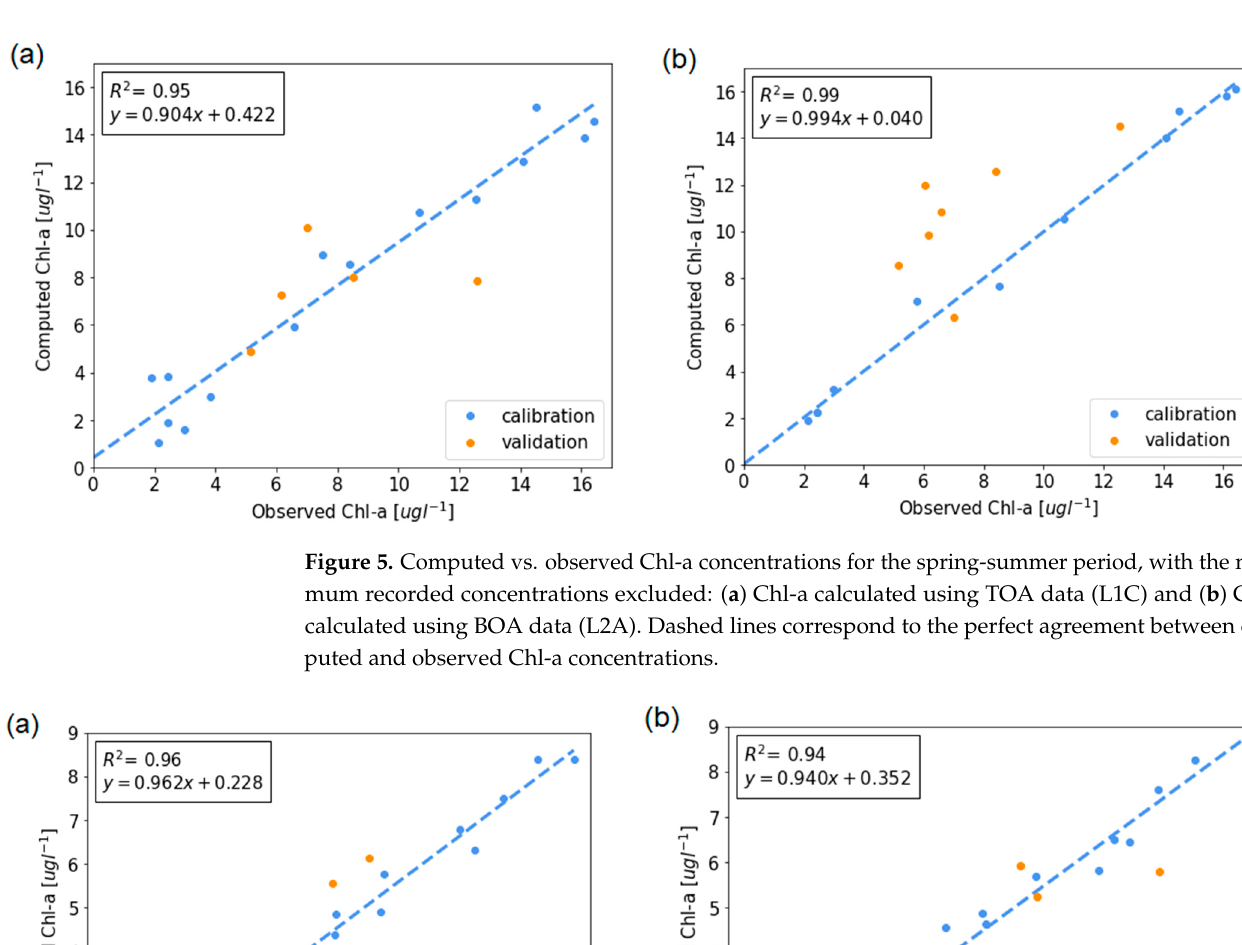
Figure 4. Computed vs. observed Chl-a concentrations for the spring-summer period, with the max- imum recorded concentrations included: ( a ) Chl-a calculated using TOA data (L1C) and ( b ) Chl-a calculated using BOA data (L2A). Dashed lines correspond to the perfect agreement between com- puted and observed Chl-a concentrations.